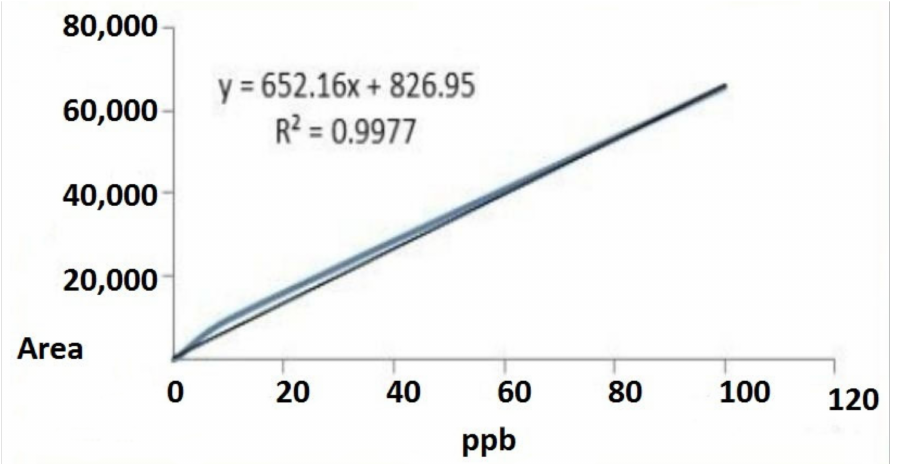
Figure 3. The acrylamide calibration standard